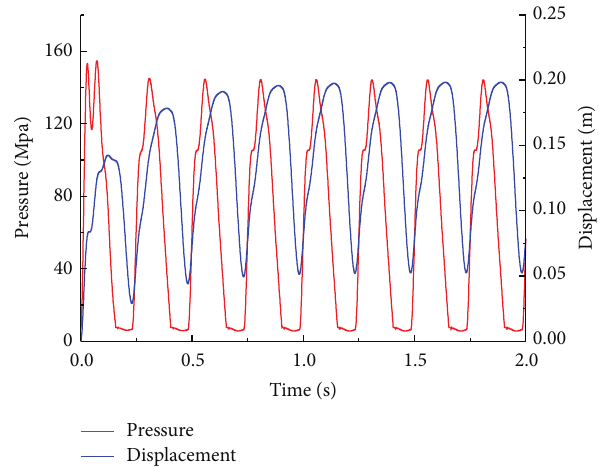
Figure 4: Simulation curve of the working behavior of the device.